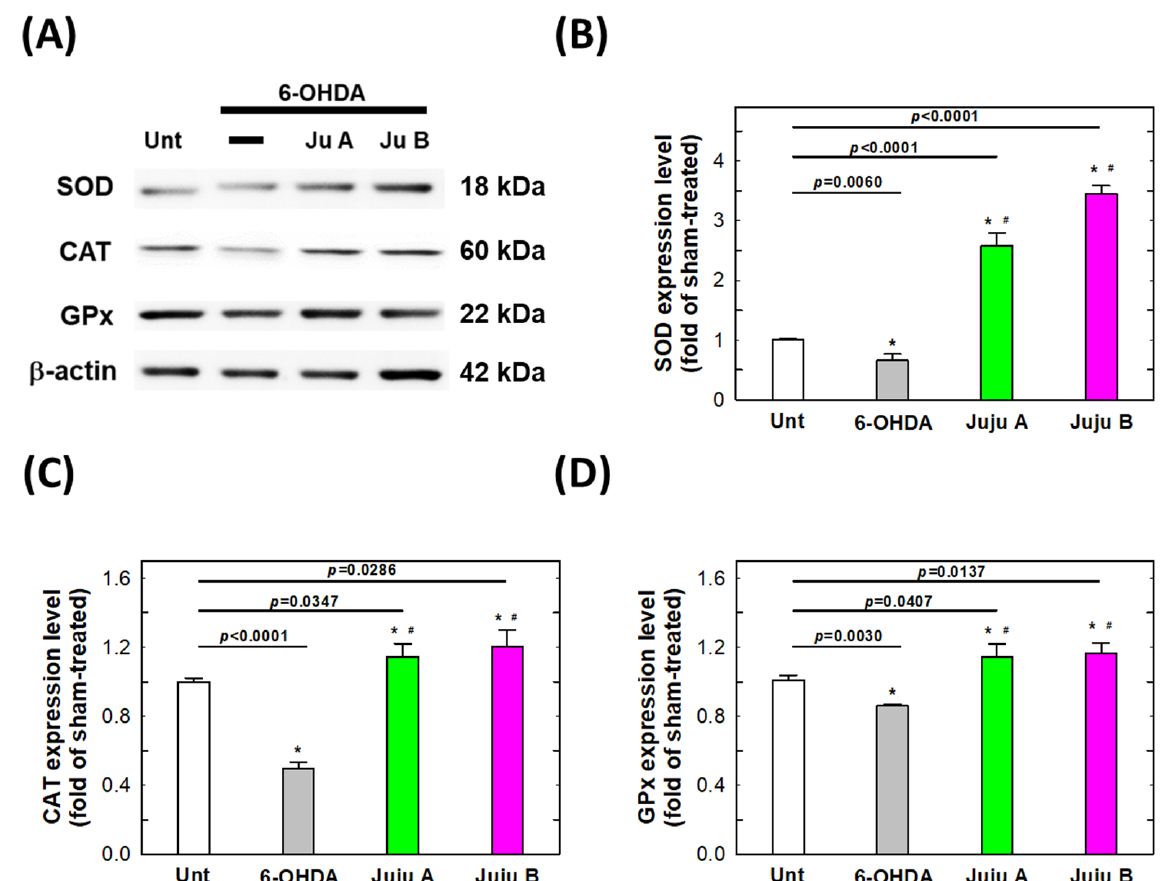
Figure 10. The signaling patterns altered by the treatments of 6-OHDA and jujubosides. ( A ) Western blotting was conducted specifically for SOD, CAT and GPx. ( B ) Quantitative analysis of the intensities of SOD bands. ( C ) Quantitative analysis of the intensities of CAT bands. ( D ) Quantitative analysis of the intensities of GPx bands. β -actin served as an internal loading control in each repeat of experiment. * significant different from untreated group. # significant different from the 6-OHDA treated group.